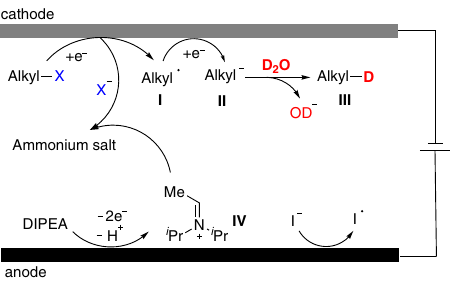
Fig. 6 A plausible mechanism. Cathodic reactions converting organic halides to deuterated product. Anodic oxidation of DIPEA and/or TBAI or DMF was occurred on